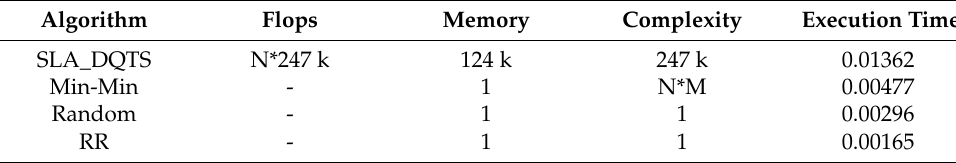
Table 3. Algorithm